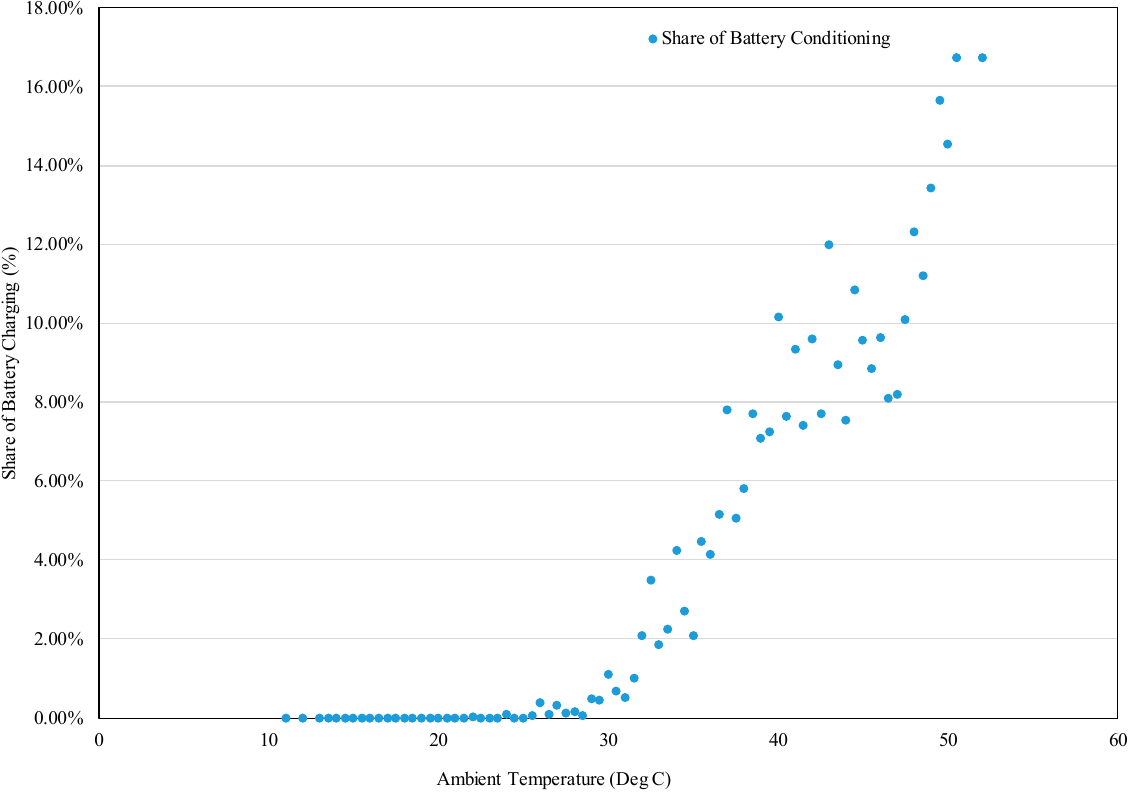
Table 3. The impact on ambient temperature on battery capacity.